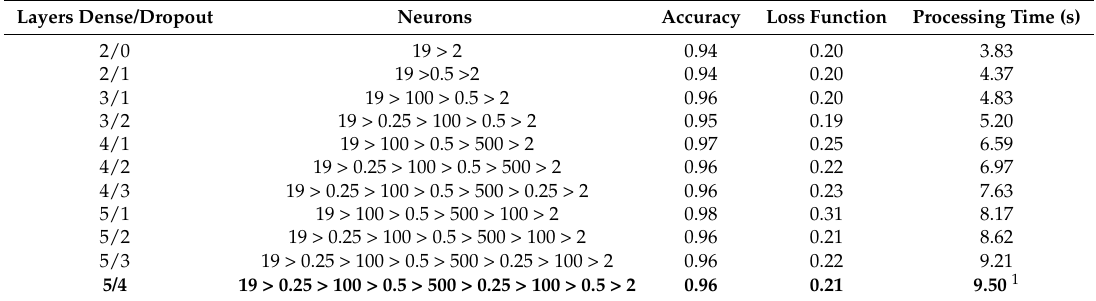
1 Structure selected for the Artificial Neural Network (ANN).